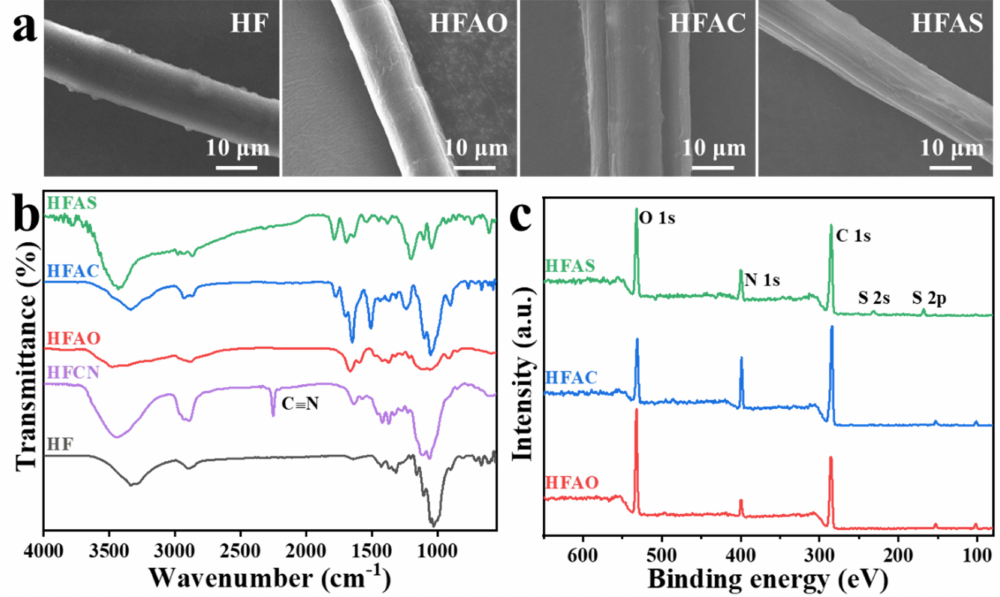
Figure 2. SEM micrographs ( a ), FTIR ( b ), and XPS spectra ( c ) of HF-based